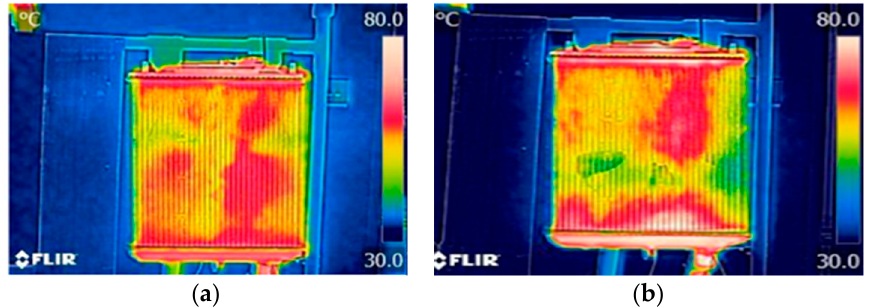
Figure 20. Thermal imaging of base fluids in the: ( a ) radiator; ( b ) nanofluids.